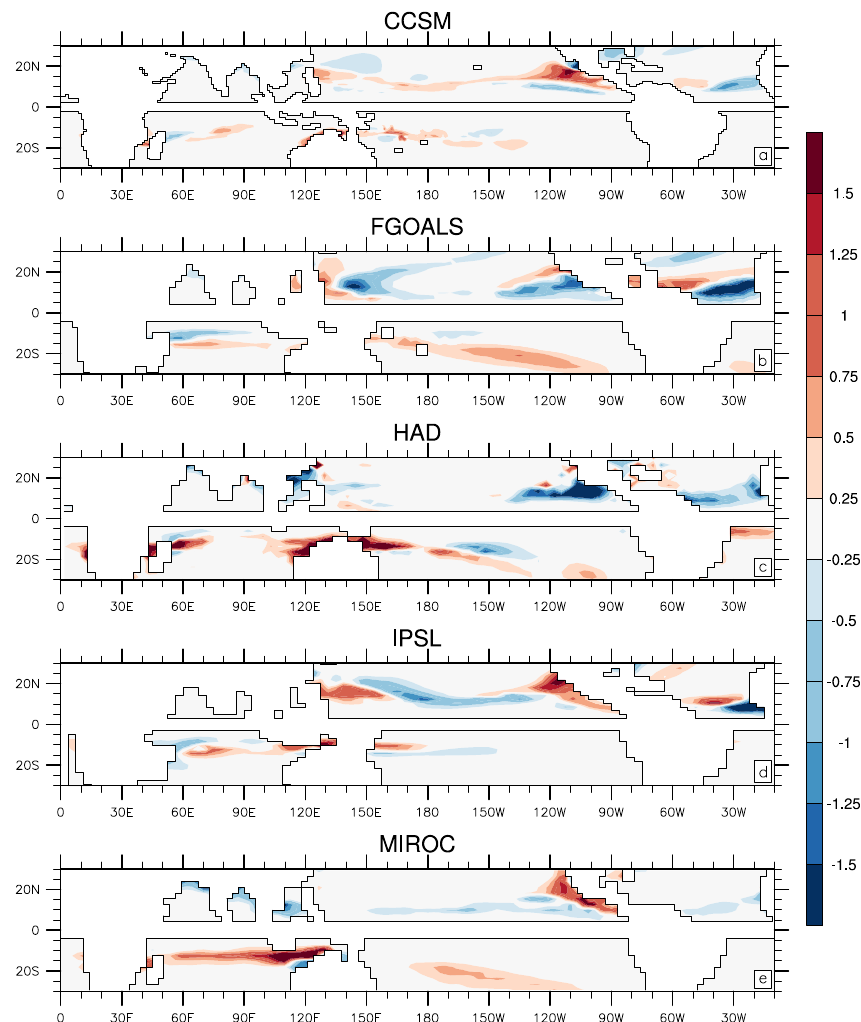
Figure 3. The difference in genesis potential index between mid-Holocene and preindustrial periods in the Northern Hemisphere (JASO) and the Southern Hemisphere (JFMA) for (a) CCSM4, (b) FGOALS, (c) HadCM3, (d) IPSL, and (e) MIROC-ESM. Units are 10 − 13